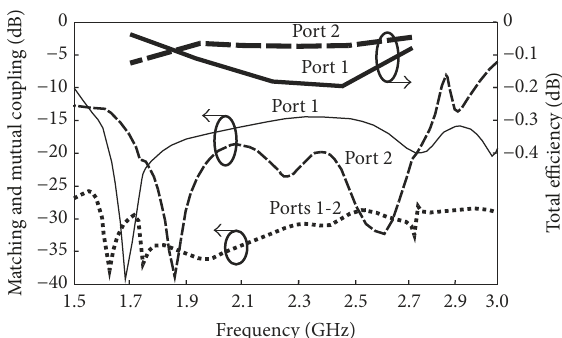
Figure 2: Simulated impedance matching, mutual coupling between the antenna ports, and total efficiency as a function of frequency.